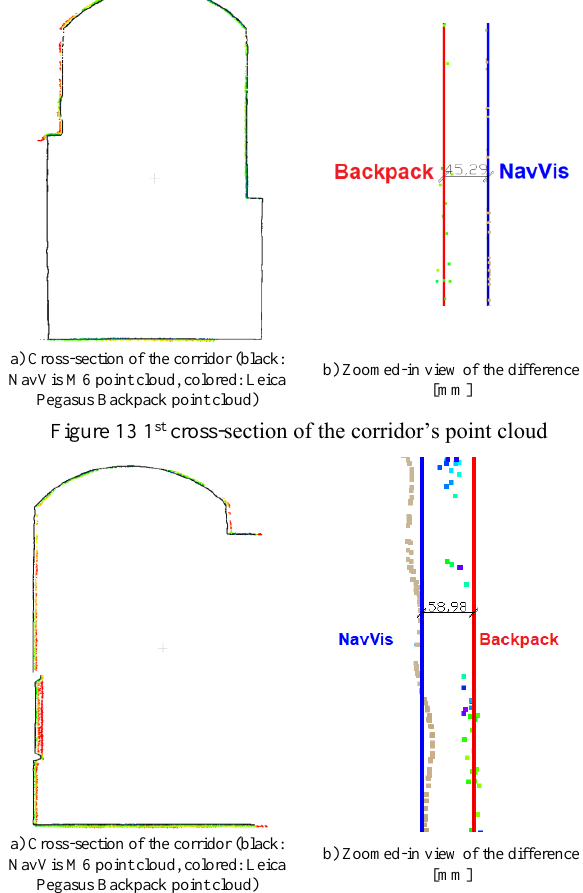
Figure 14 2 nd cross-section of the corridor’s point